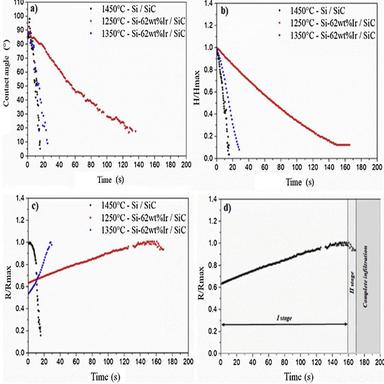
Evolution of contact angles and drop geometric variables (R-drop base radius and H-drop height) recorded within the infiltration experiments performed on Si/SiCp-C at T = 1450 °C and Si-Ir eutectic alloy/SiCp-C at T = 1250 °C, 1350 °C; a) evolution of contact angle, b) evolution of normalized drop height and c) evolution of normalized base radius, d) stages in the evolution of the normalized base radius.